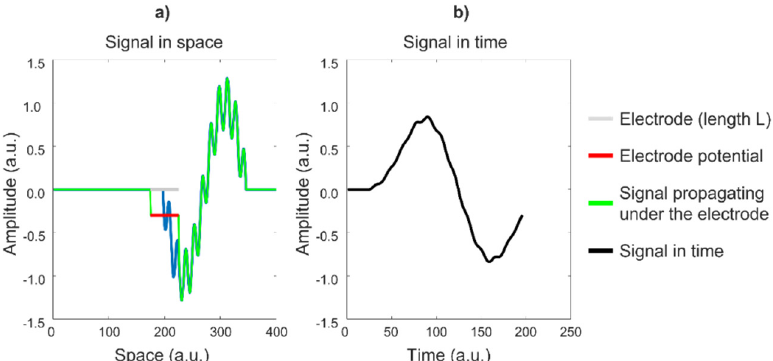
Figure 18. Effects of electrode length on a signal: ( a ) the green signal propagates in space under the gray fixed electrode of length L, generating the instantaneous signal indicated by the red bar. The signal evolves in time, as depicted in panel ( b ). (See animation in Supplementary Materials, Sup10). Courtesy of Dr. Alberto Botter.